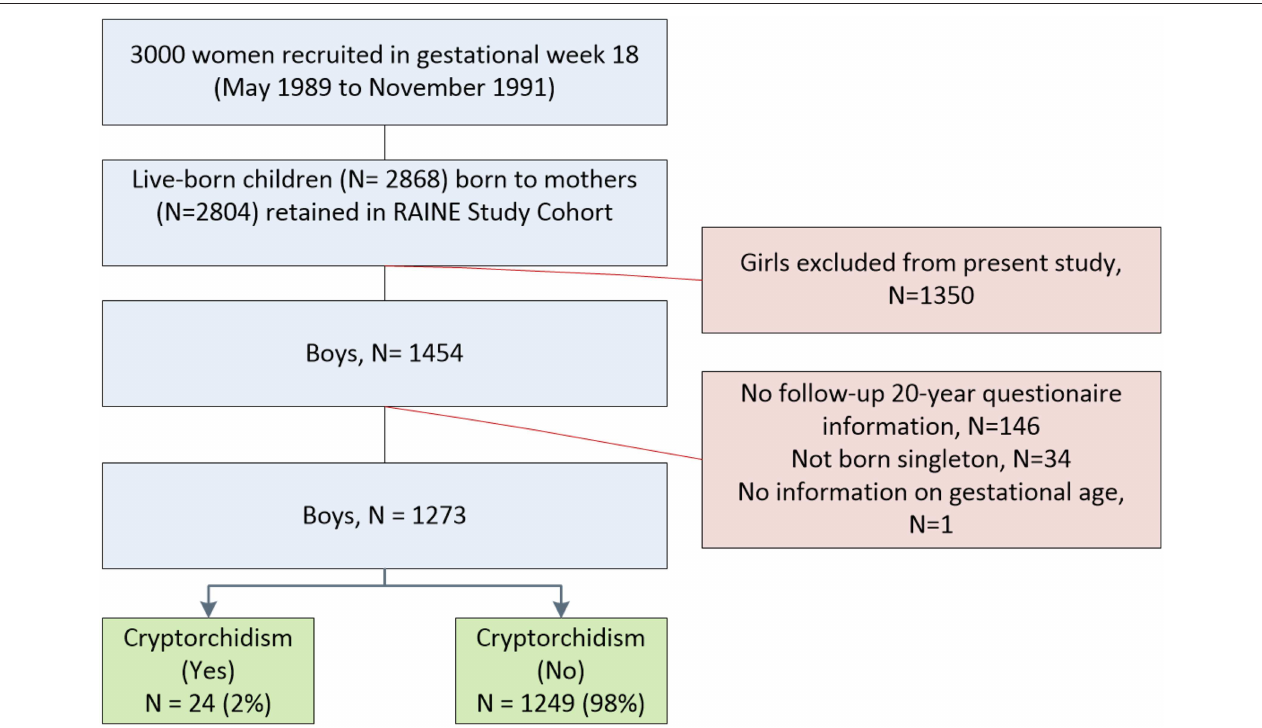
FIGURE 1 | Study population and